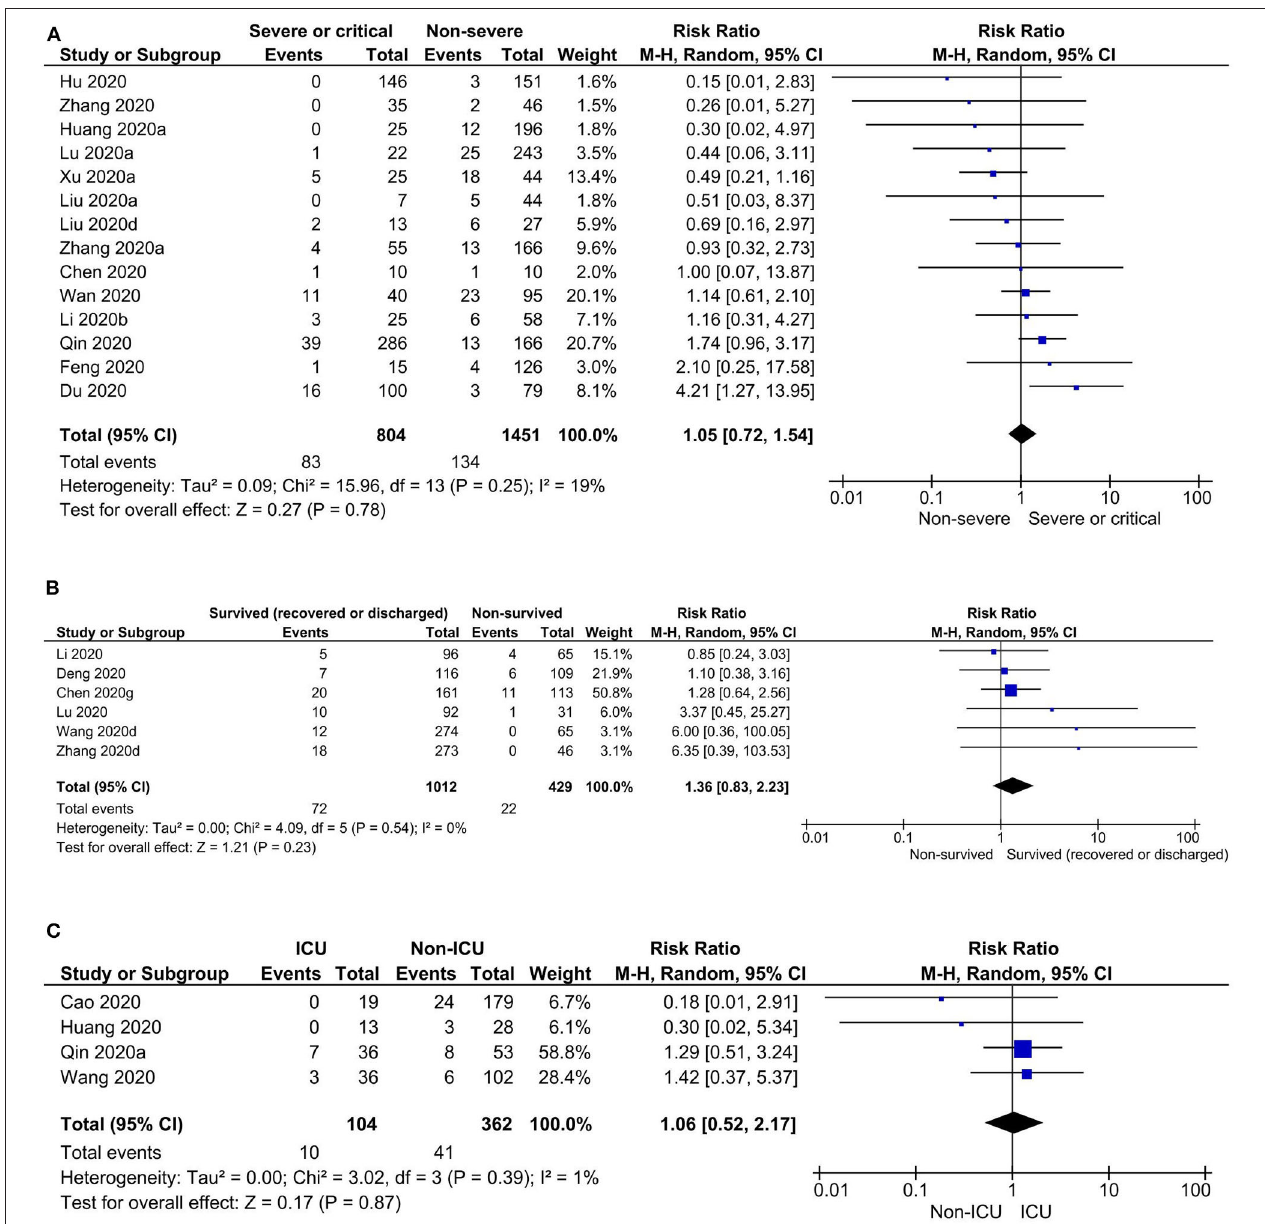
FIGURE 3 | Risks of headache in (A) severe or critical vs. non-severe, (B) survived (recovered or discharged) vs. non-survived, and (C) ICU vs. non-ICU COVID-19 patients.